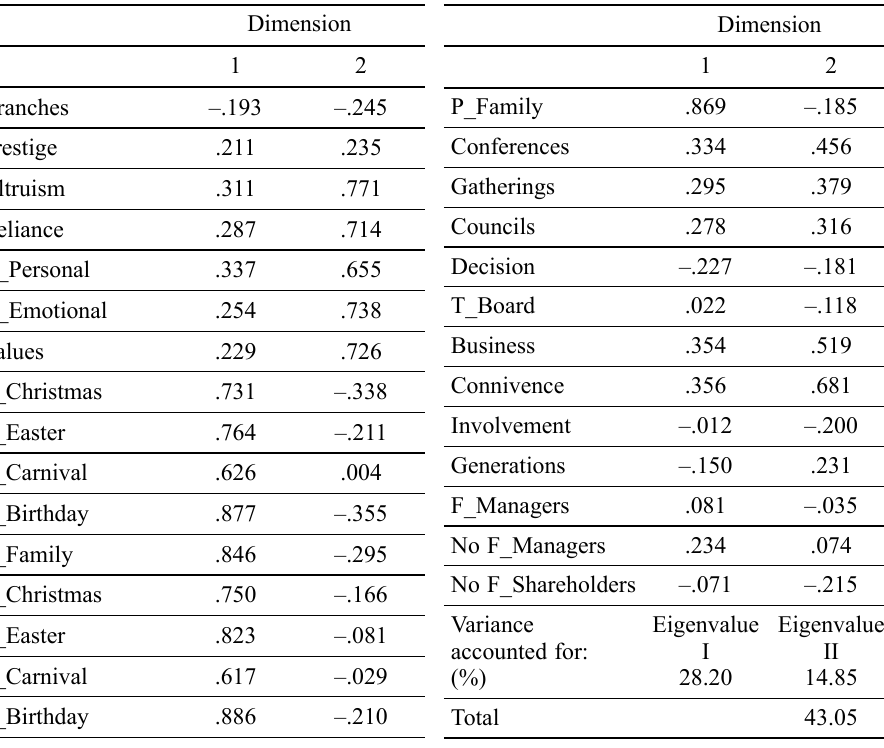
Table 3. Component